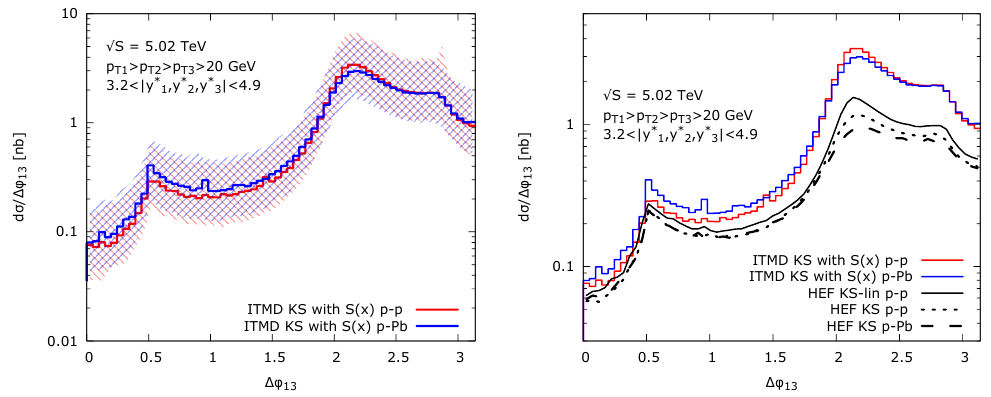
Figure 5 . Di(cid:11)erential cross sections in the azimuthal angle between the hardest jet and the softest jet, (cid:1) (cid:30) 13 , for p-p and p-Pb collisions. Left plot represents the calculation with uncertainty due to scale variation. Right plot shows the comparison of the ITMD and HEF for central values.